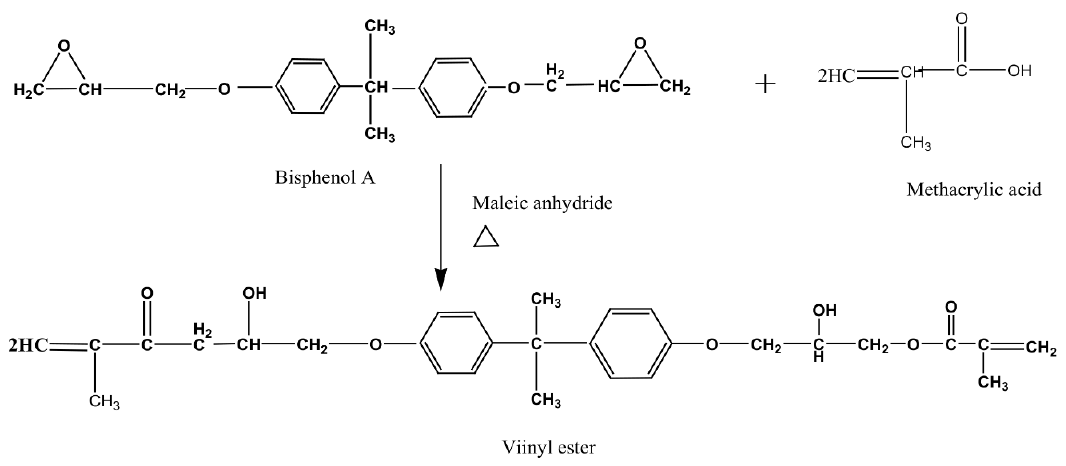
Figure 11 . The reaction of bisphenol A and methacrylic acid with maleic anhydride as a catalyst at a temperature between 90-120°C to form a vinyl ester resin.